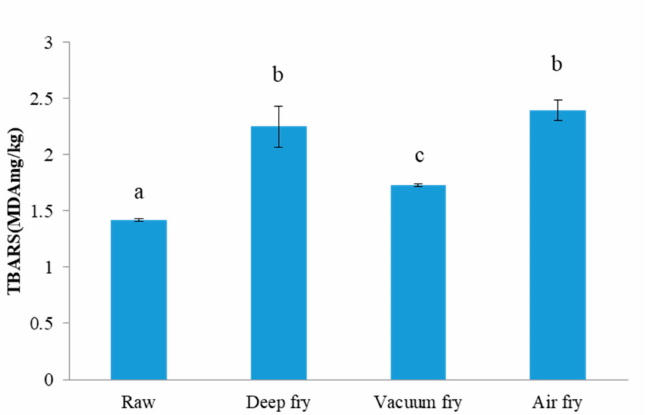
Figure 4. Thiobarbituric acid-reactive substances (TBARS) produced by chub mackerel ( Scomber japon- icus ) after using different frying methods. Data are presented as mean ± SD. Different superscript letters (a–c) show significantly different values according to Duncan’s test ( p <